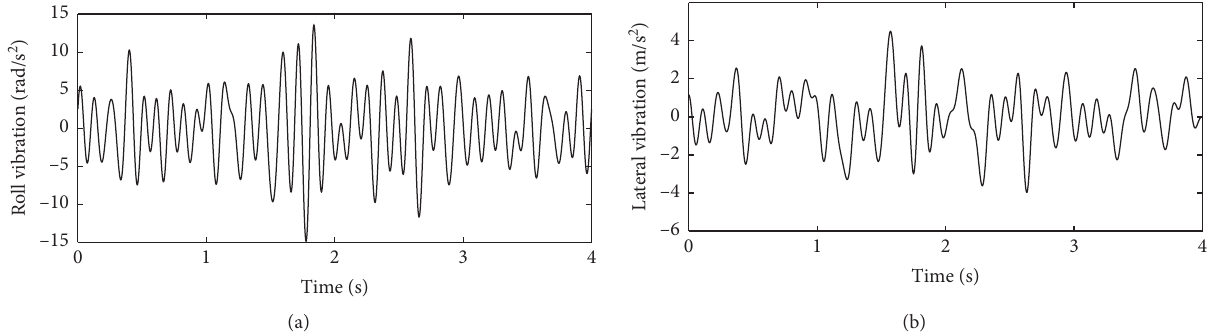
Figure 12: Equivalent 7.4rad/s 2 r.m.s. roll excitation and 1.4m/s 2 r.m.s. lateral excitation.